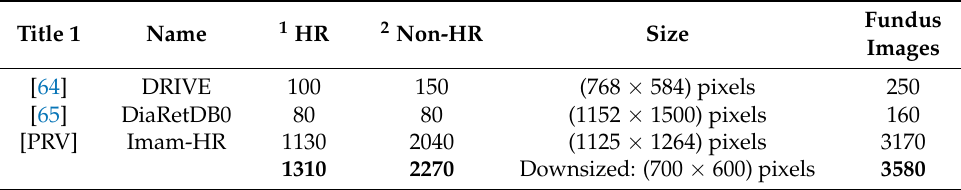
Table 2. Retinal fundus datasets used with the CAD-HR-diagnosis